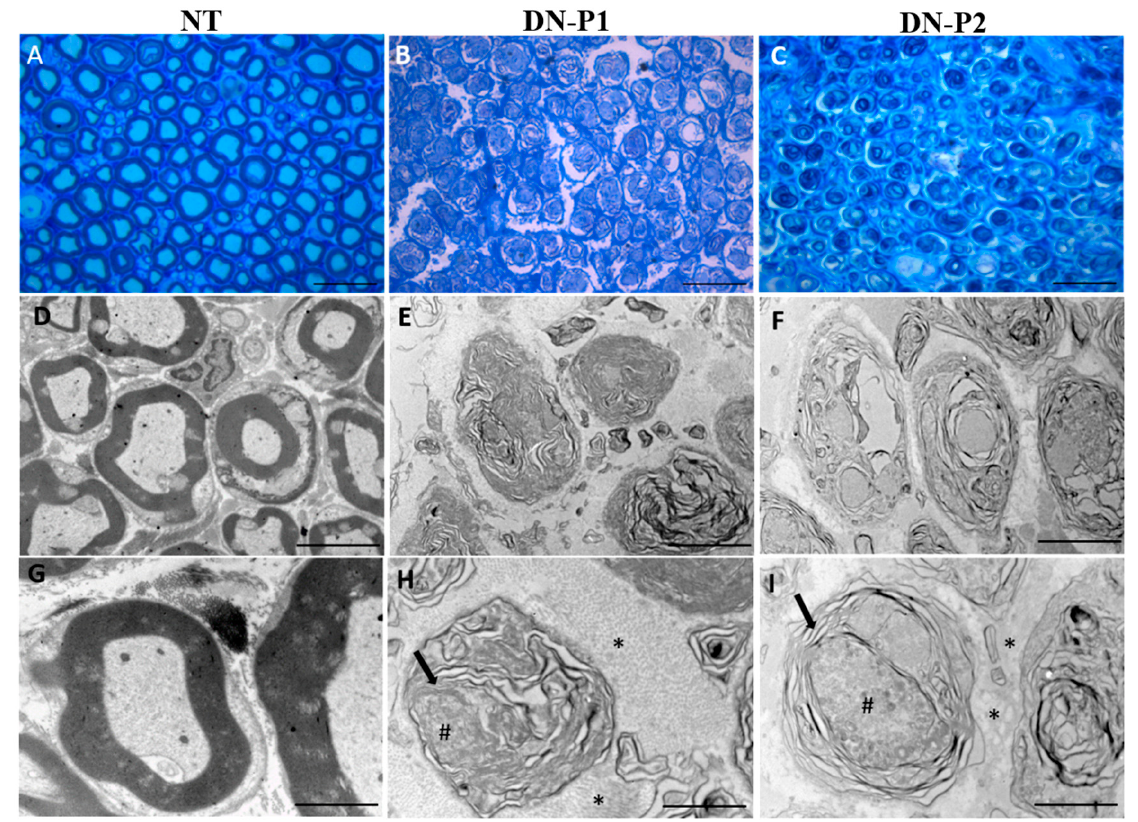
Figure 6. Toluidine blue staining and Ttansmission electron microscopy (TEM) representative panel. Toluidine blue stained sections ( A – C ) show the overall structure of the decellularized rat sciatic nerves. TEM ( D – I ) detects the changes in the inner ultrastructure of the native tissue and decellularized nerves. Myelin structures (black arrow), collagen fibers (*), axon remnants (#). ( A – C ) scale bar = 20 µm; ( D – F ) scale bar = 5 µm; ( G – I ) scale bar = 2 µm.